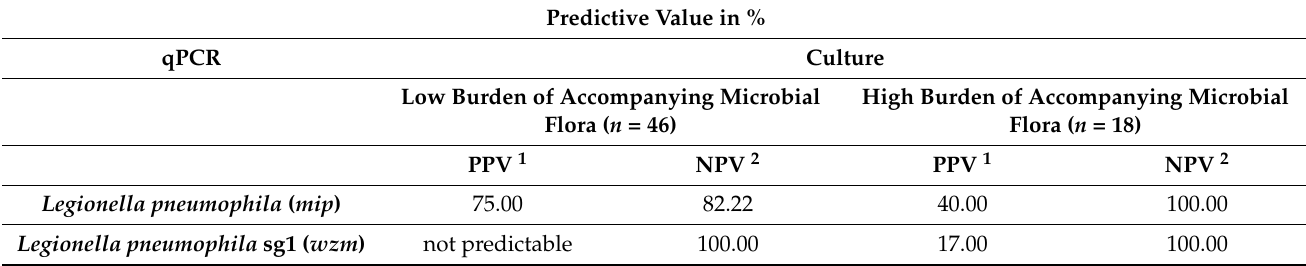
Table 4. Predictive values of qPCR for L. pneumophila and L. pneumophila sg 1 culture results, established from the L. pneumophila qPCR for the mip gene and the L. pneumophila sg 1 qPCR for the wzm gene, in comparison with the culture for samples with a low and high burden of the accompanying microbial